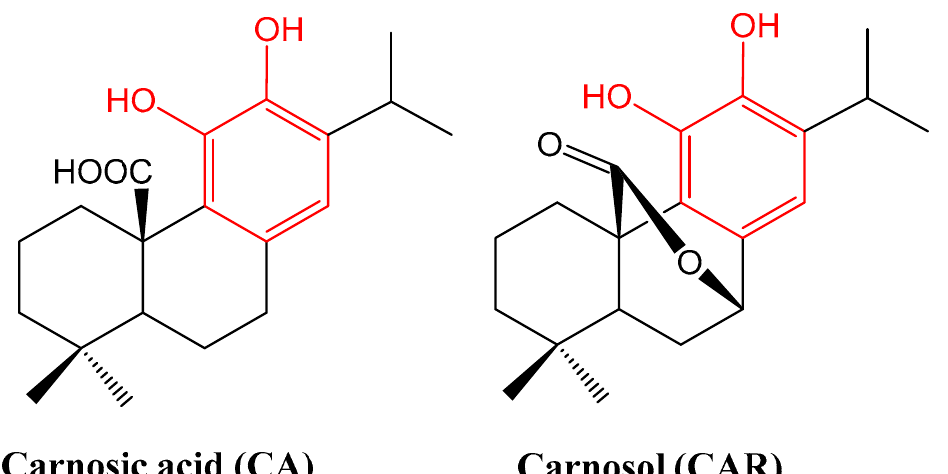
Figure 1. Structures of carnosic acid and carnosol. One common structural moiety for the two compounds is the orthodihydroxybenzene (catechol) group shown in red. This makes them similar to polyphenolic compounds such as flavonoids, which are known for their general antioxidant properties. They are also made from the 20-carbon diterpene skeleton. The concentration of CA can be up to 5-fold higher than CAR, but oxidation under various conditions can transform it into other products including CAR [17].